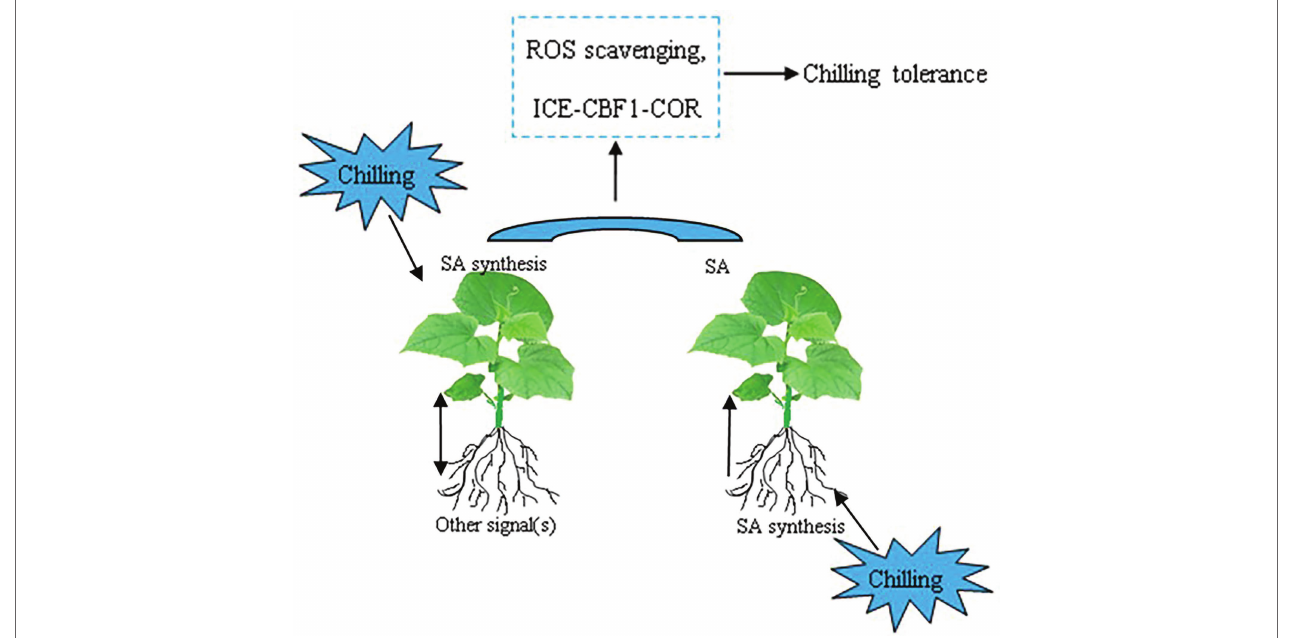
FIGURE 9 | Simplified schematic model for SA-induced expression of COR genes and chilling tolerance in grafted cucumber plants responding to chilling stress. The original contributions presented in the study are publicly available. These data can be found here: Gene Expression Omnibus of NCBI, Sequence Read Archive (SRA) accession no: PRJNA701131